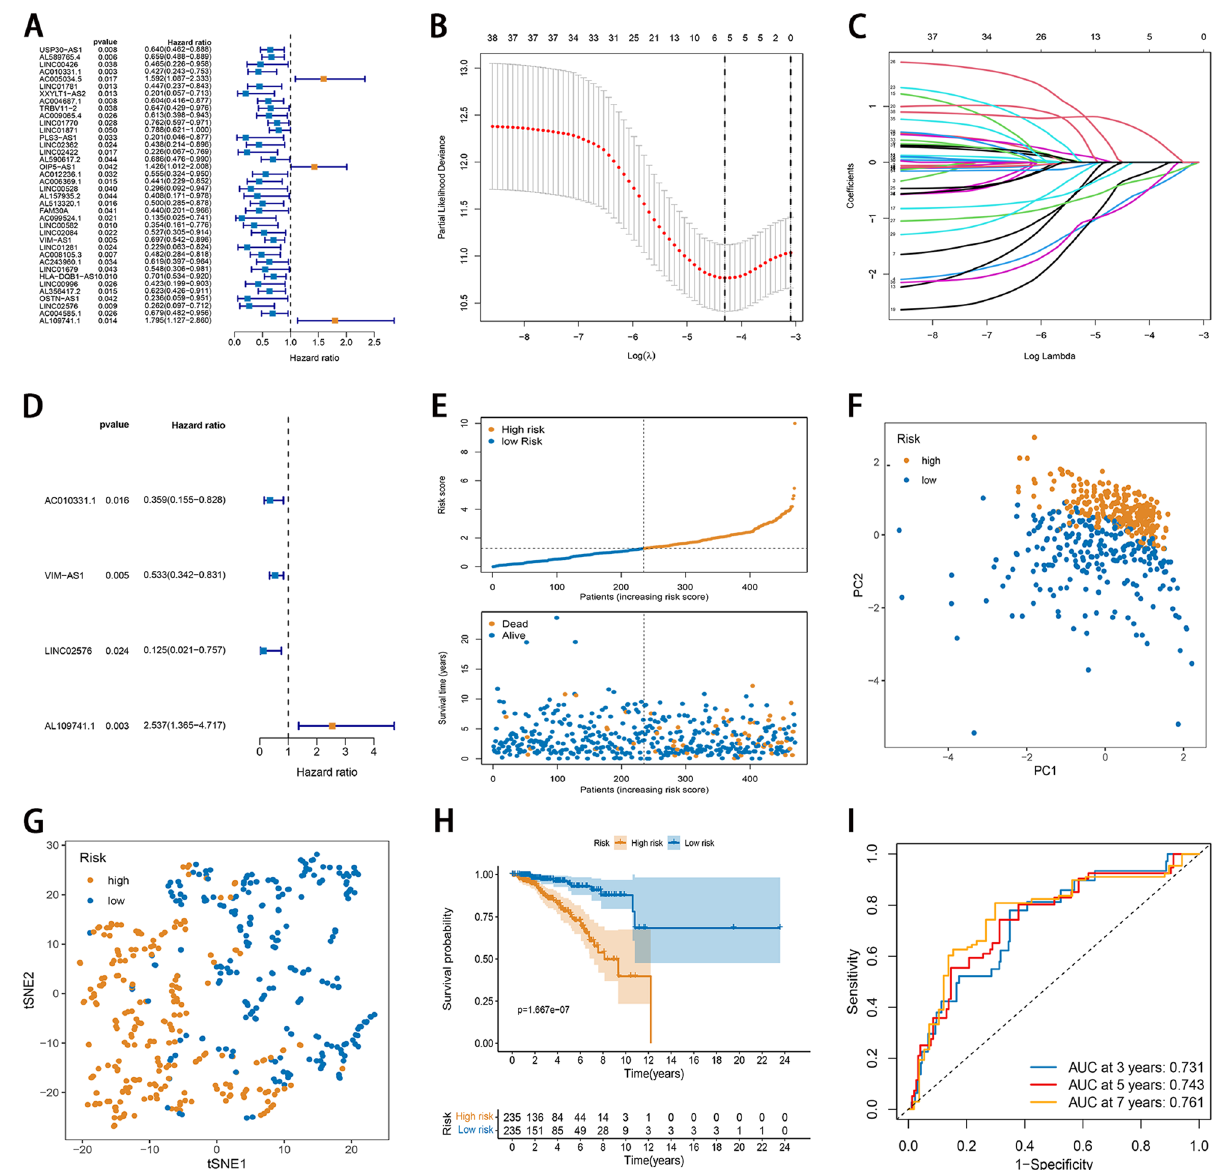
Figure 2. Development of necroptosis-related lncRNA signature in the training set. ( A ) The NRGs closely related to the prognosis of breast cancer patients were screened by univariate Cox regression analysis. ( B ) Regression coefficient profiles of identified NRLs in the TCGA cohort. ( C ) Ten-time cross-validation for tuning parameter selection. ( D ) Forrest plot showed that a total of 4 NRLs were identified as prognosis-related by multivariate cox analysis. ( E ) The distribution and value of the risk scores. ( F ) PCA of breast cancer patients according to the risk score. ( G ) t-SNE of breast cancer patients according to the risk score. ( H ) Kaplan–Meier curves for OS in high- and low-risk groups. ( I ) ROC curve analysis shows the predictive efficiency of the established